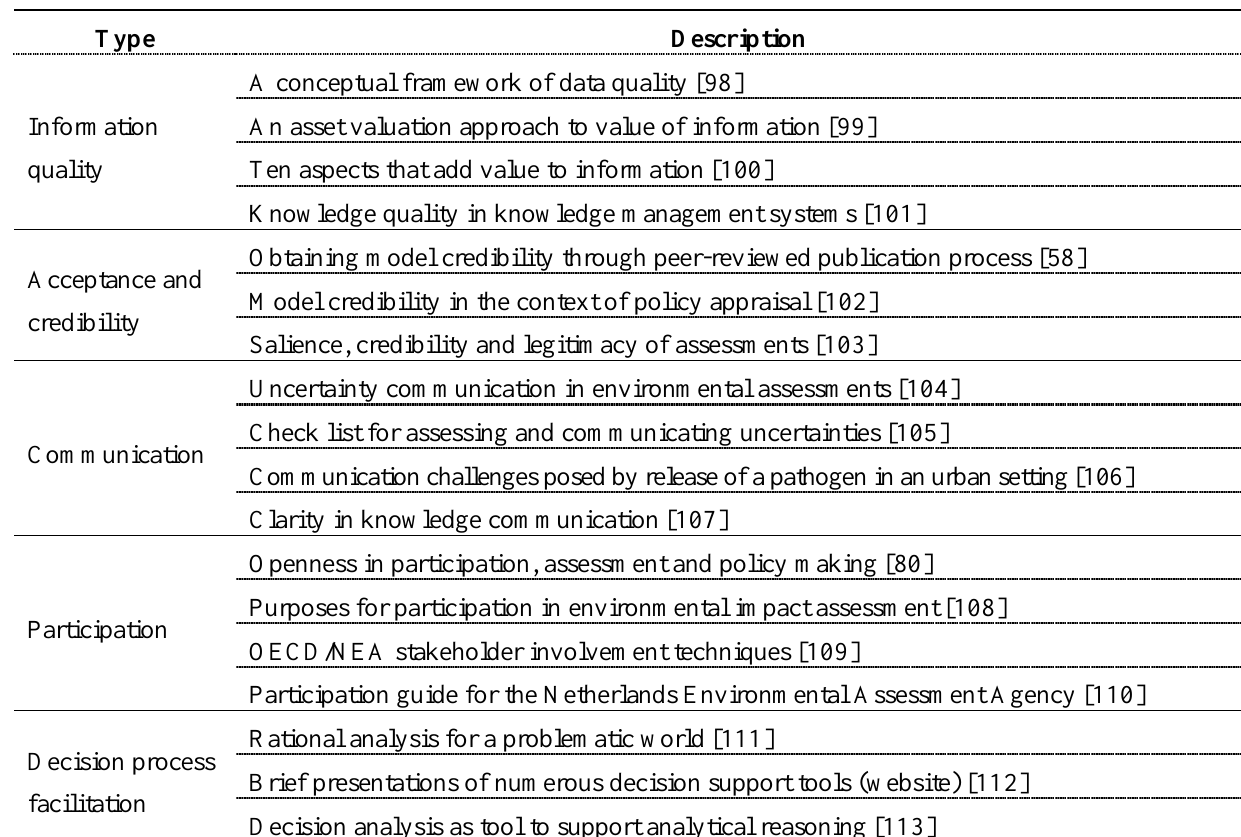
Table 5. Examples of other perspectives to assessment and model